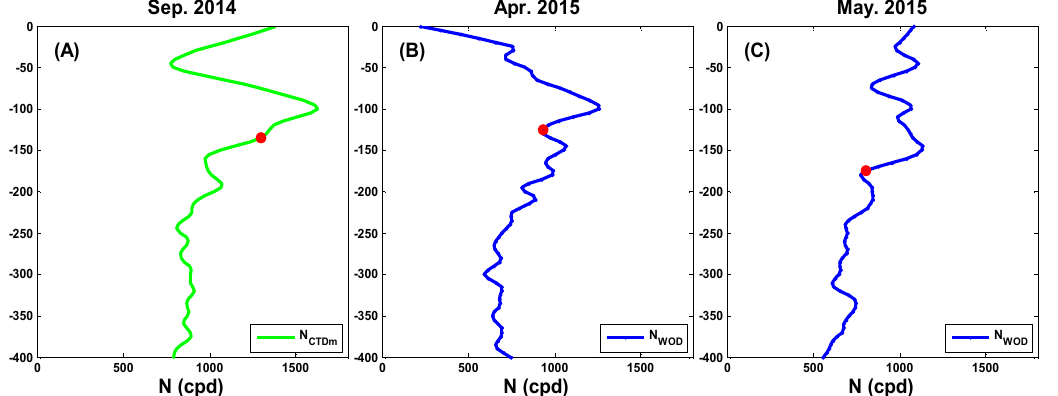
Figure 6. Regional average buoyancy frequency N calculated from the ARGO profiles (blue lines) and cruise conductivity temperature depth (CTD) profile (green line) during ( A ) the first NIO (in September 2014), ( B ) the second NIO (in April 2015), and ( C ) the third NIO (in May 2015). The horizontal axis of the figure is the Buoyancy frequency with the unit cpd. The vertical axis is water depth with the unit m. The red circle is the maximum NIKE depth. The selected sea area for the second and third NIOs was 100 km around the mooring location. No ARGO data were available for within 100 km of the mooring for the first NIO.